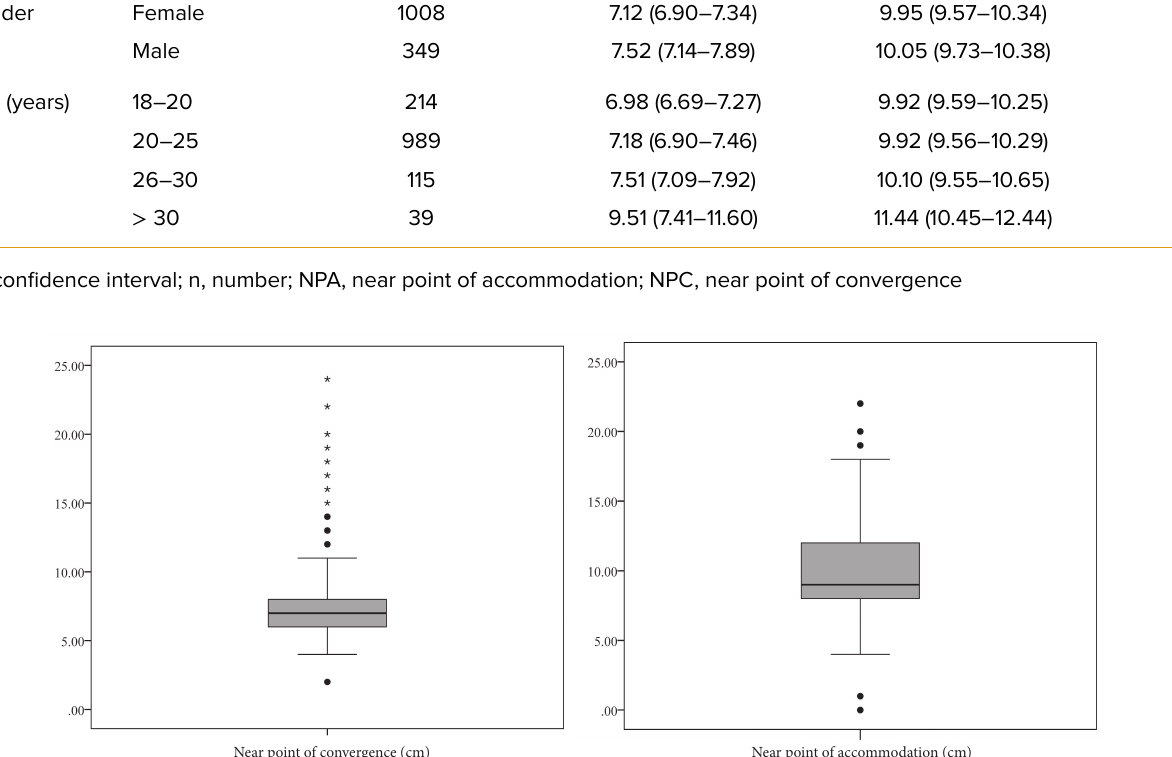
NPA increased from 9.92 cm in 18–20 years olds to 11.44 cm in those over 30 years ( 𝑃 =